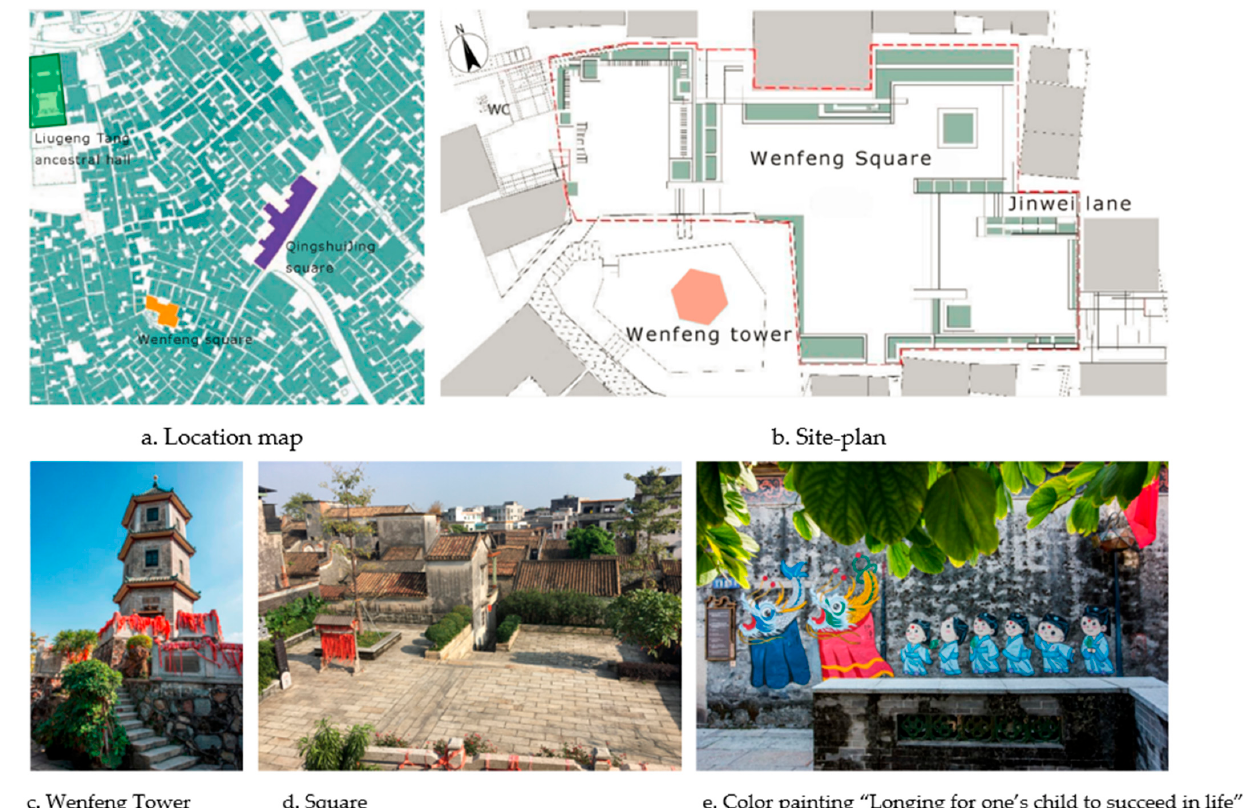
Figure 16. Wenfeng Square transformation (Source: [31]).